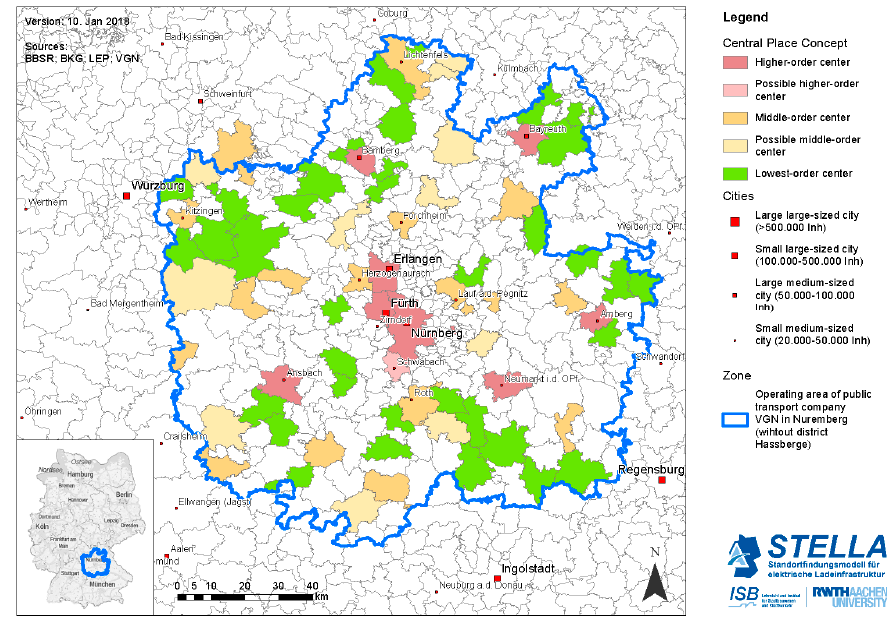
Figure 3. Classification of the traffic network metropolitan area of Nuremberg on the basis of the “Central Places Concept” (own depiction based on [15,16,31,33]).